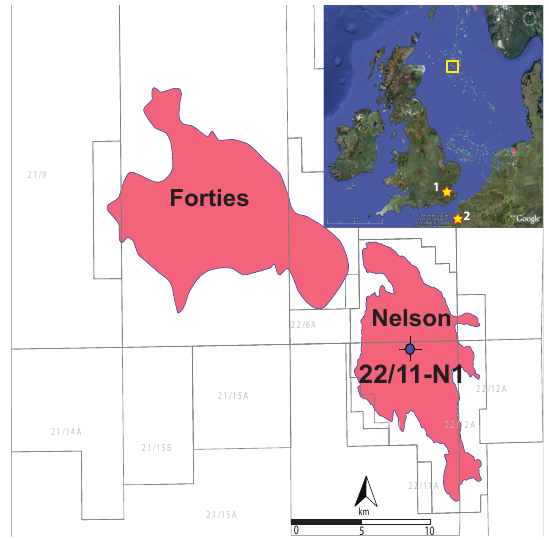
Fig. 1. Location map of 22/11-N1, Nelson Field, central North Sea (CNS). Colored polygons representing oil and gas fields. Red stars represent the location of recent studies on the (1) Cobham Lig- nite (Collinson et al., 2009) and (2) Vasterival section, NW France (Storme et al., 2012; Garel et al.,